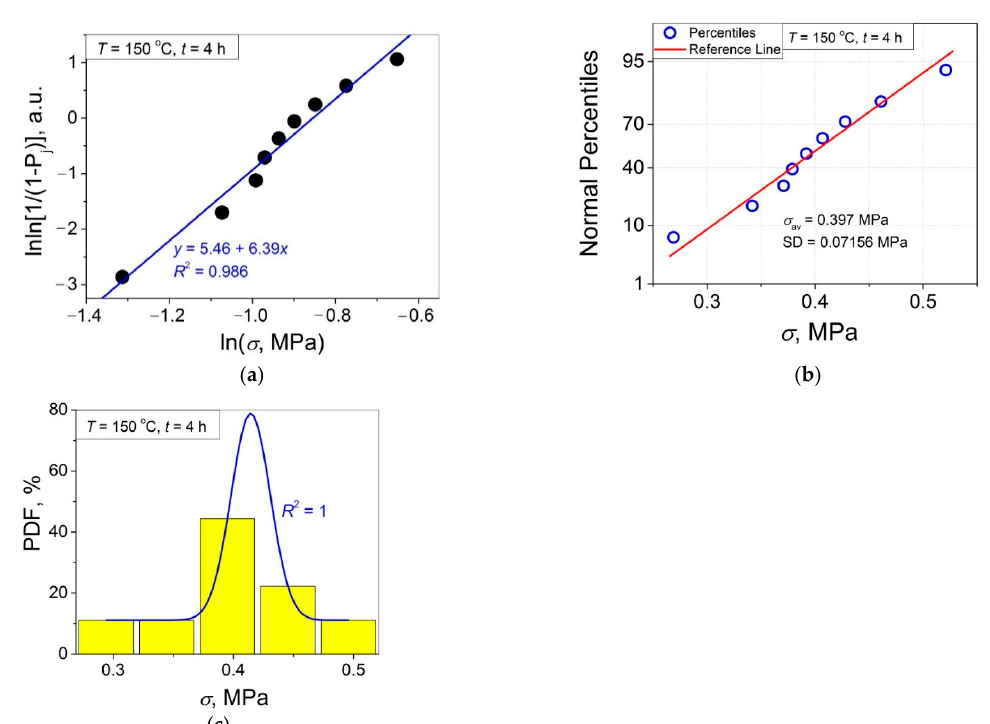
Figure 12. ( a ) Linear regression fit of the lap shear strength σ in Weibull’s coordinates; ( b ) normal probability plot; ( c ) probability density function (PDF) vs. σ fitted with a Gaussian function for an amorphous PET–PET interface self-bonded at T = 150 °C for t = 4 h.